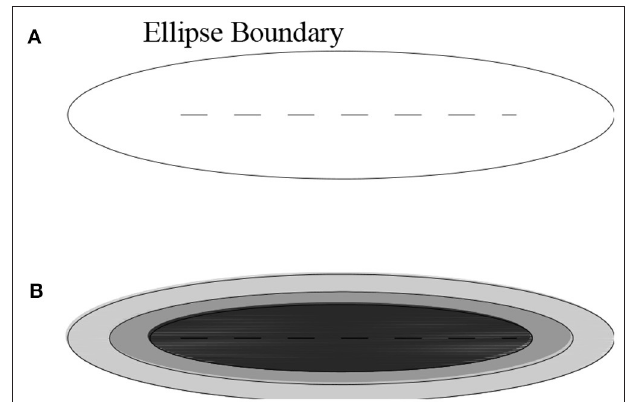
FIGURE 1 | (A) The ellipsoid area, defined by the aspect ratio ( 4 ), encompasses all fractures surrounding the major faults. (B) Concentric ellipsoidal shells around the major fault in (A) . Each shell contains equal fractures, and thus, the resultant fracture density decreases gradually toward the outside. The darker area means a greater fracture density.